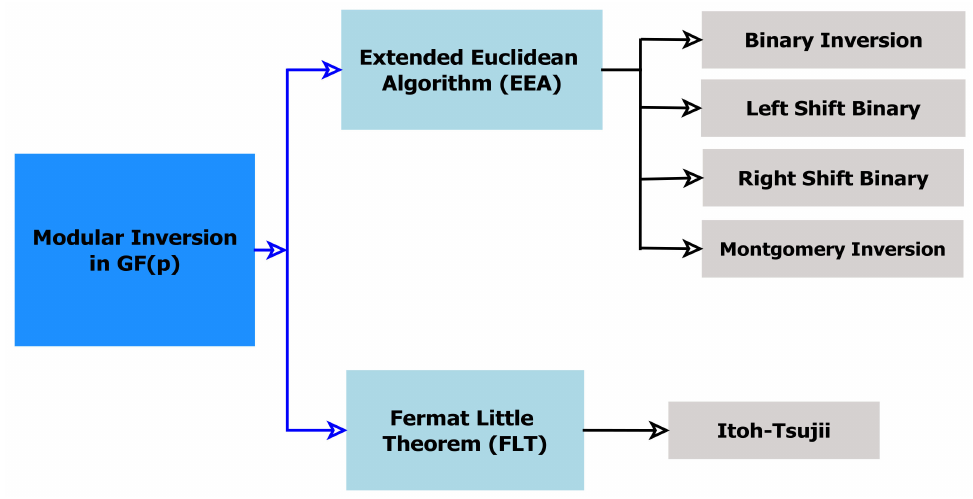
Figure 1. Modular inversion methods in F p .